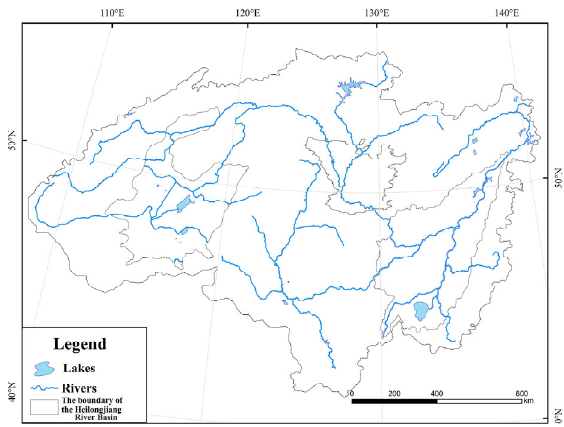
Figure 1. Location diagram of Heilongjiang Basin.